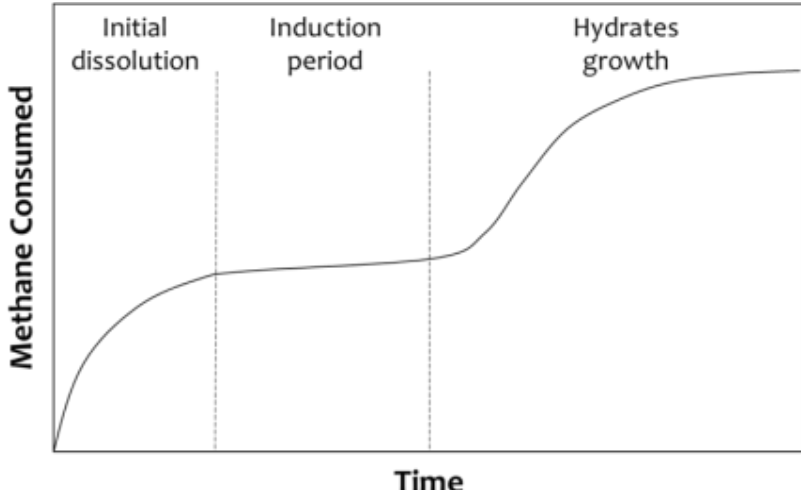
Figure 2. Three typical stages of methane consumption versus time during the hydrate formation